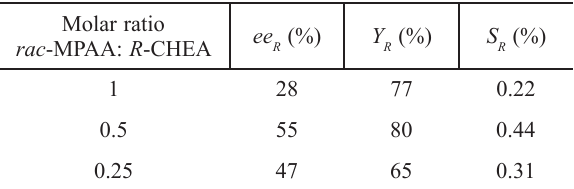
Table 3 – Effect of molar ratio on diastereomeric salt forma- tion. Reaction condition: 40 °C at 12 MPa pressure, 21 g CO solvent, 1